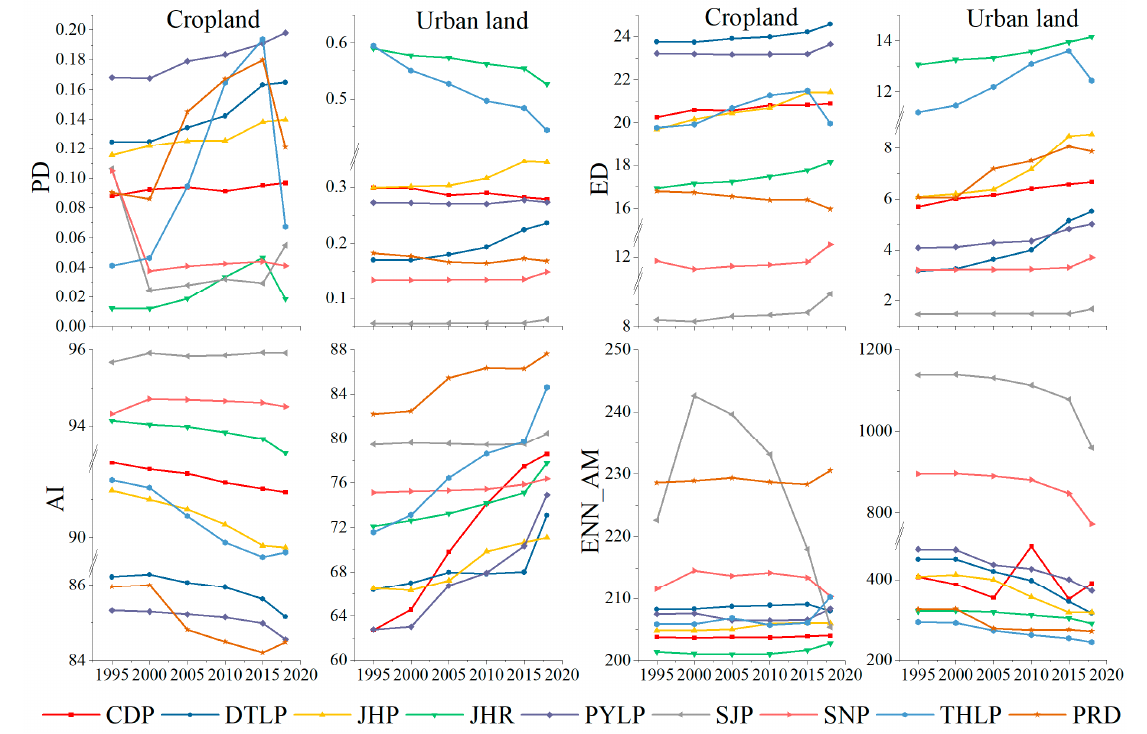
Figure 8. Changes in landscape metrics of cropland and urban land at class level,